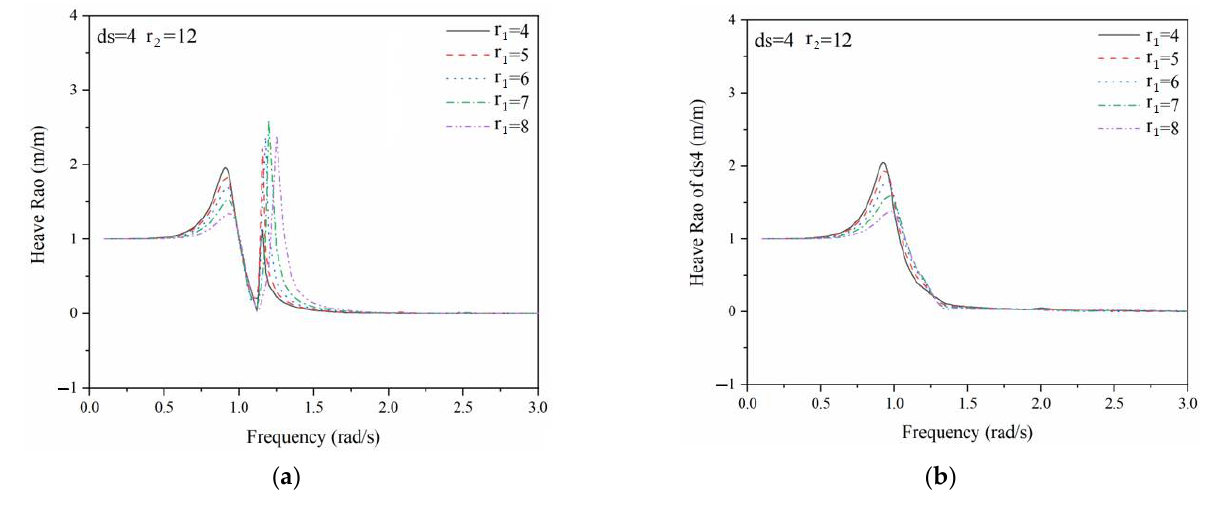
Figure 7. Heave RAO with different inner radius WEC. ( a ) Heave RAO. ( b ) Heave RAO after adding a lid.